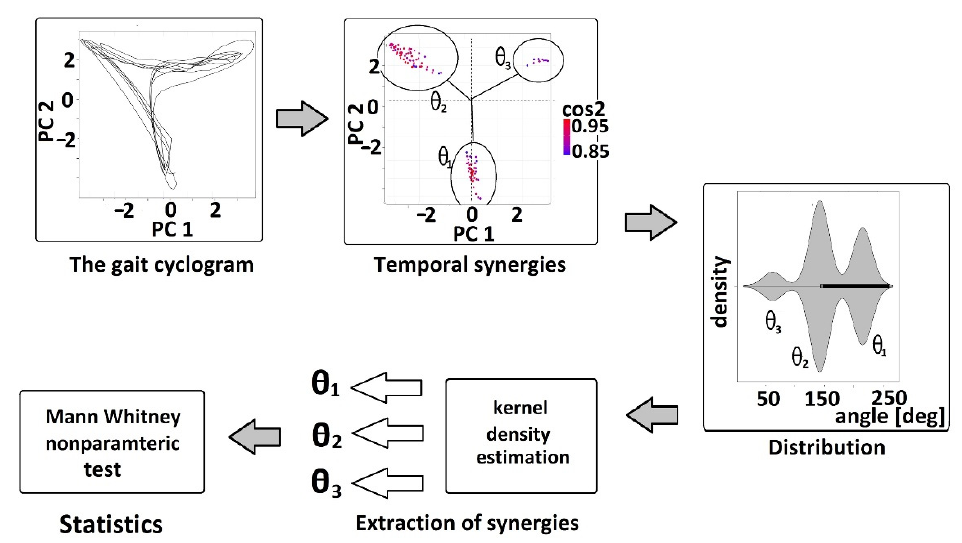
Figure 5. Temporal synergies detection from the PCA gait cyclograms.